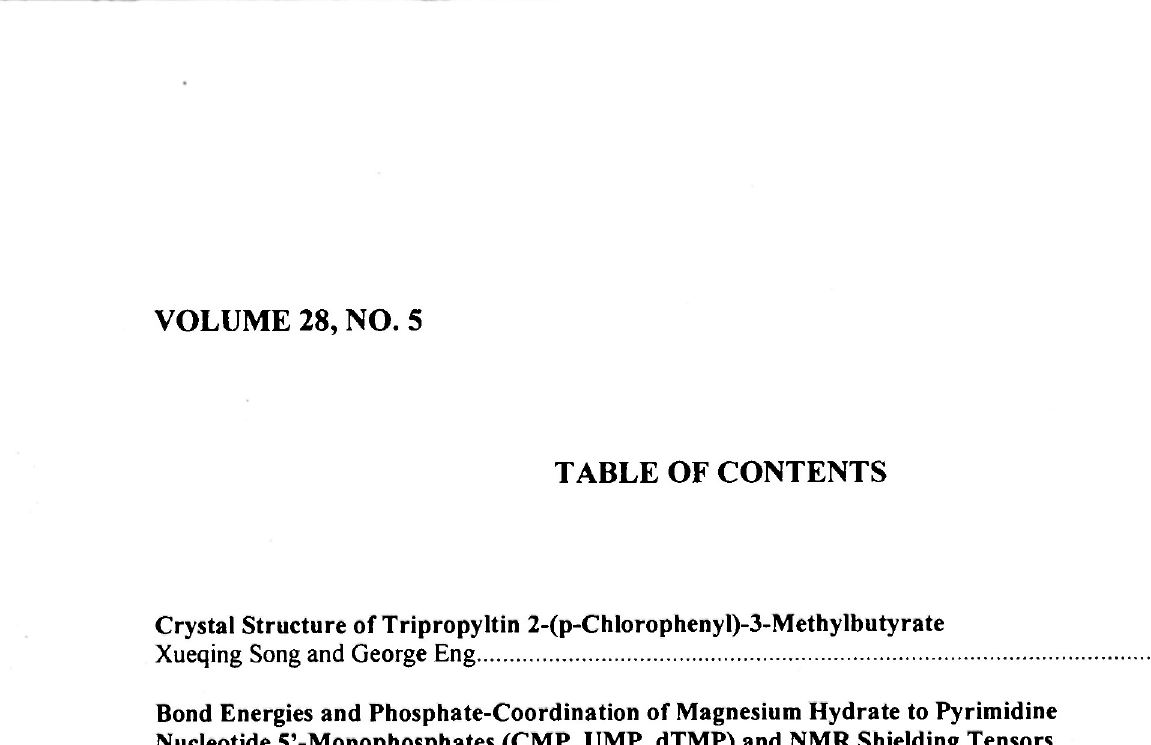
Crystal Structure of Tripropyltin 2-(p-Chlorophenyl)-3-Methylbutyrate Xueqing Song and George Eng 243 Bond Energies and Phosphate-Coordination of Magnesium Hydrate to Pyrimidine Nucleotide 5'-Monophosphates (CMP, UMP, dTMP) and NMR Shielding